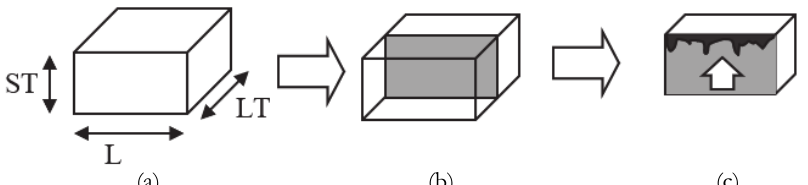
Figure 2: Procedure for the analysis of the corroded profiles. (a) Sample to be immersed in the testing solution; (b) cut along the LT-ST plane; (c) corroded profile observed.